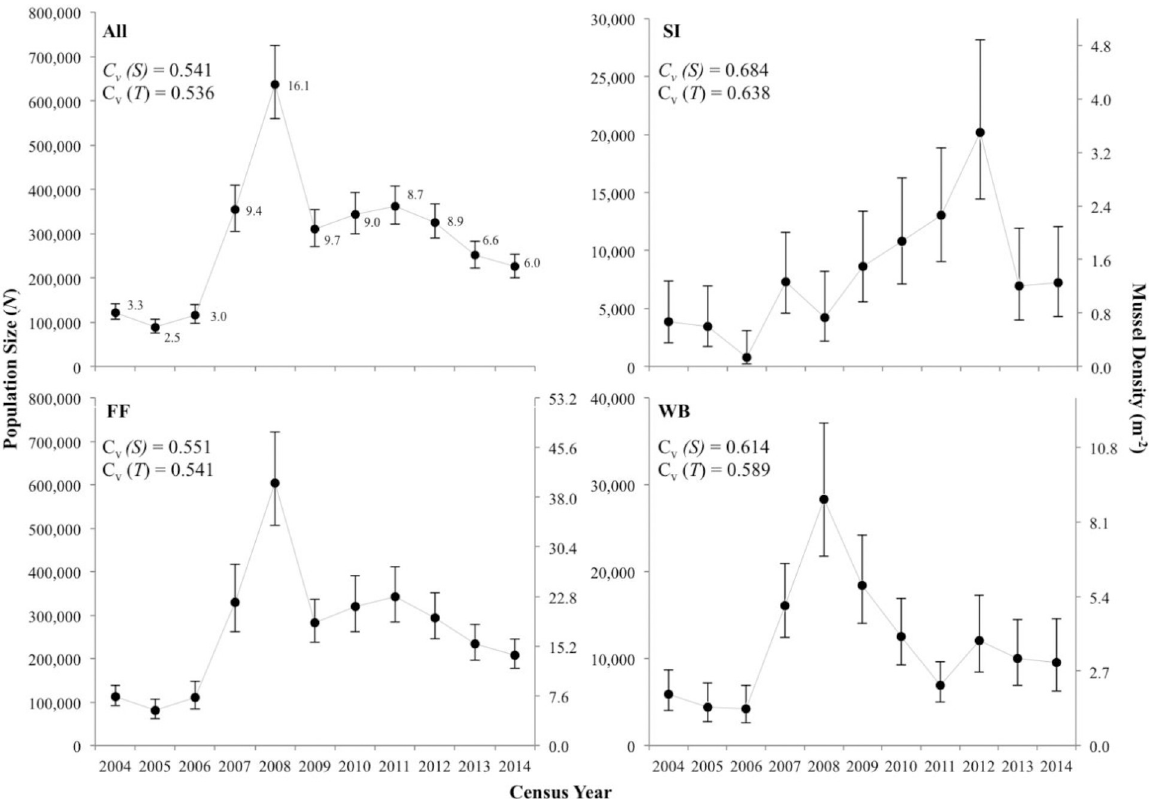
Fig 3. Estimates of population size ( N ) and mean density (bars represent 95% confidence limits corrected for non-normality) for Epioblasma capsaeformis in the Clinch River, Hancock County, TN, at Frost Ford (FF), Swan Island (SI), Wallen Bend (WB), and averaged across all three sites (All) from 2004–2014. Numbers next to point estimates on All plot indicate average density across the 3 sites. The value C v ( S) is the total coefficient of variation measured in the time series, which includes both sampling error variance S 2 ( ^ N ) and true temporal process variance. The value C v (T) is true temporal process variation, after mean S 2 ( ^ N ) was removed from C v ( S)